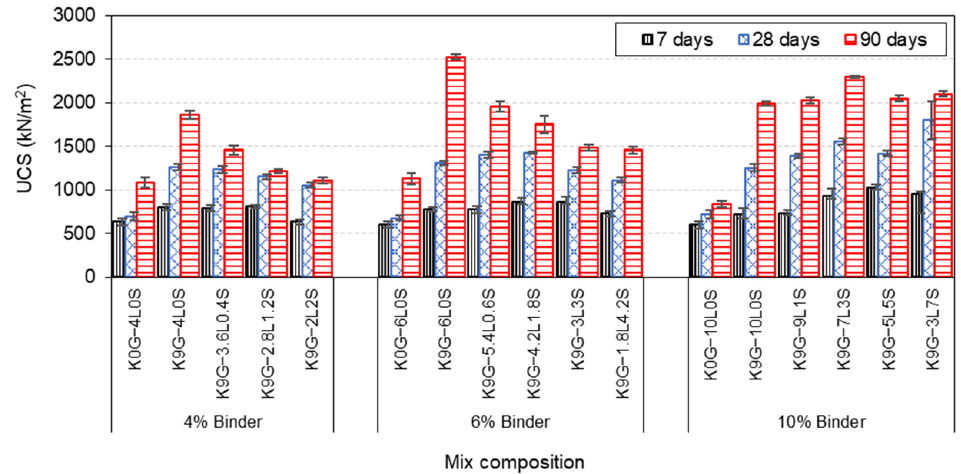
Figure 5. UCS of kaolinite specimens made with various binary blends of lime and silica fume at varying binder dosages (4, 6, and 10 wt%).